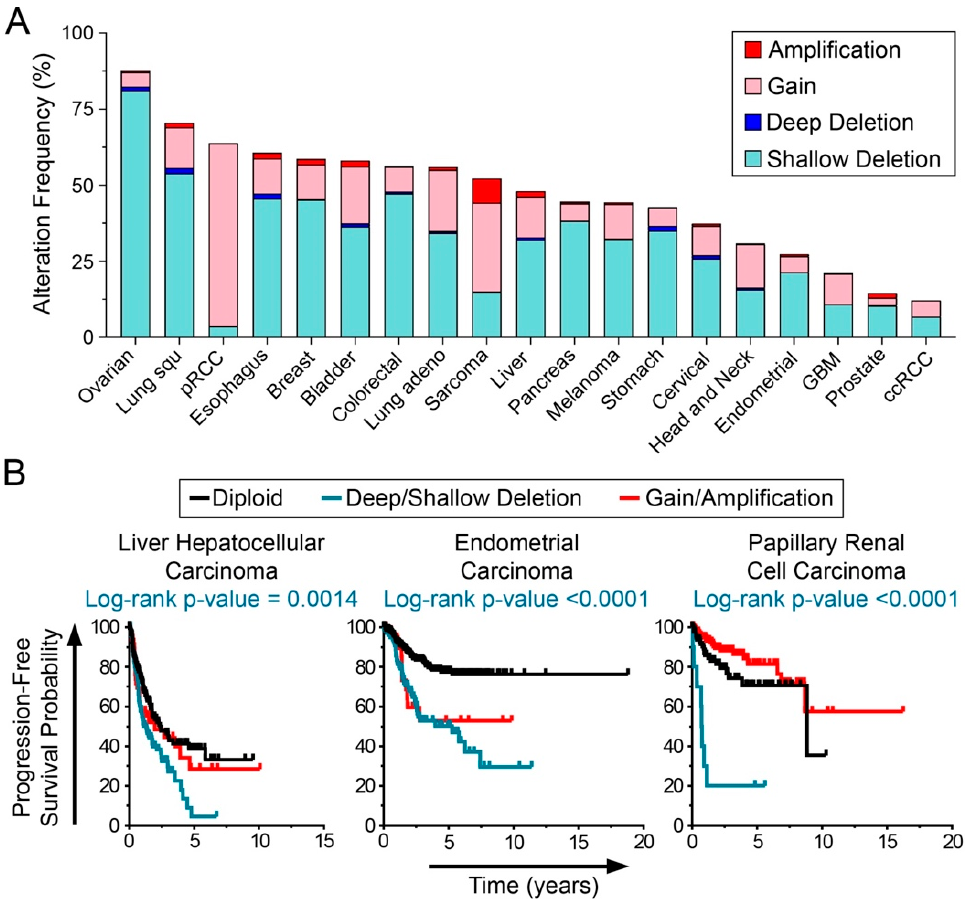
Figure 7. USP22 deletions occur frequently in cancer. ( A ) Frequency of USP22 alterations (shallow deletions, deep deletions (i.e., homozygous loss), gains and amplifications) in 19 cancer types [68,69]. Lung squ: lung squamous cell carcinoma; pRCC: papillary renal cell carcinoma; Lung adeno: lung adenocarcinoma; GBM: glioblastoma multiforme; ccRCC: clear cell renal cell carcino- ma. Note that USP22 is deleted (deep/shallow) in 10–80% of most cancers. ( B ) Kaplan–Meier curves comparing patient progression-free survival based on USP22 copy number status (i.e., dip- loid, deep/shallow deletions or gain/amplification) reveal that USP22 deletions correlate with worse patient survival in multiple cancer types. Log-rank p -values compare outcomes between diploid and deep/shallow deletions.